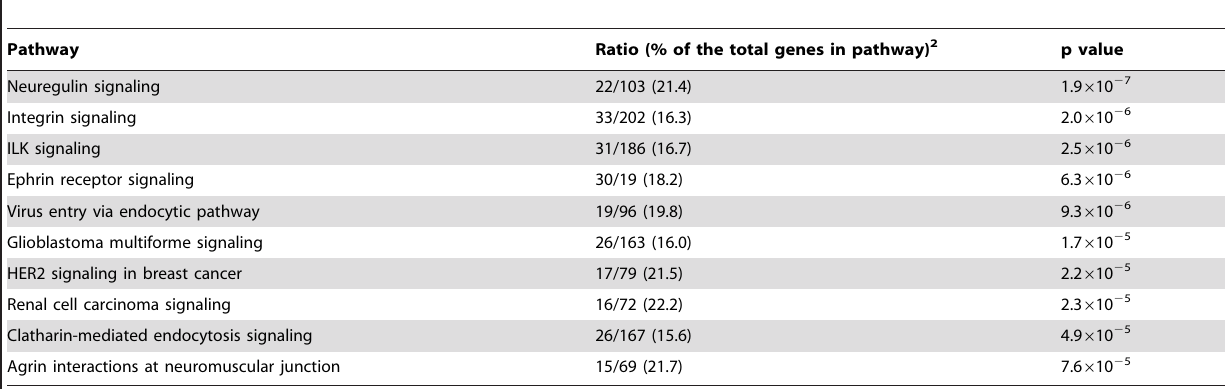
Table 4. Canonical Pathways Dominant in Human Airway Epithelium Basal Cells Compared to the Differentiated Complete Airway Epithelium.